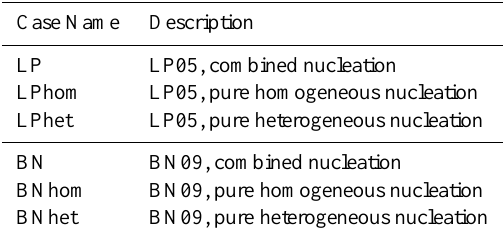
Table 1. CAM5 cases in this